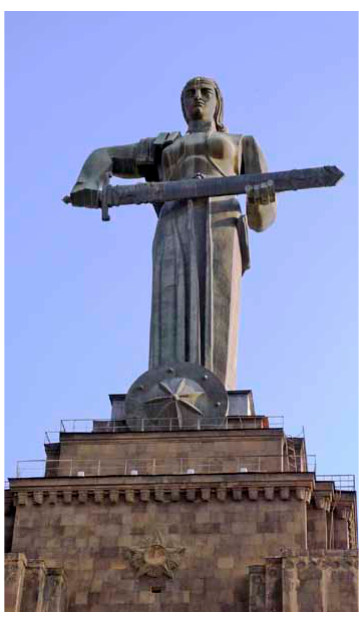
fig. 3. Victory monument in Kyiv, ukraine. r. Čepai- tienė